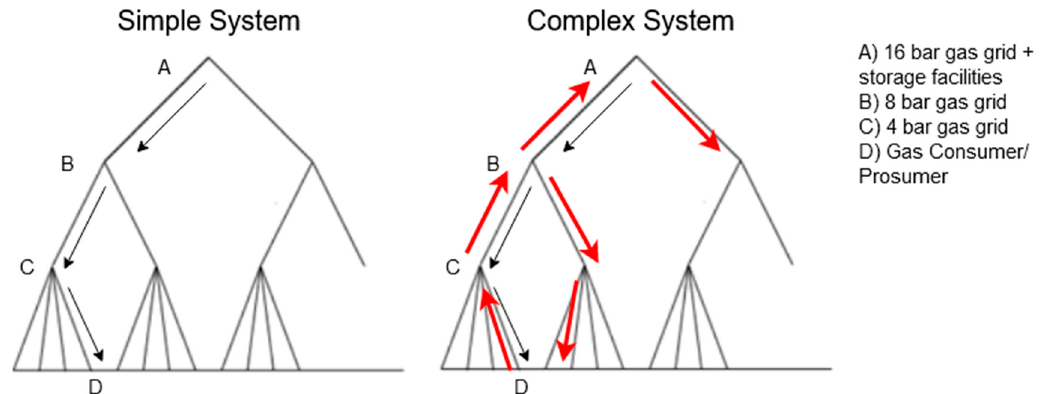
Figure 1. Visual representation of the difference between a simple and a complex gas system, figure adapted from Reference [23].